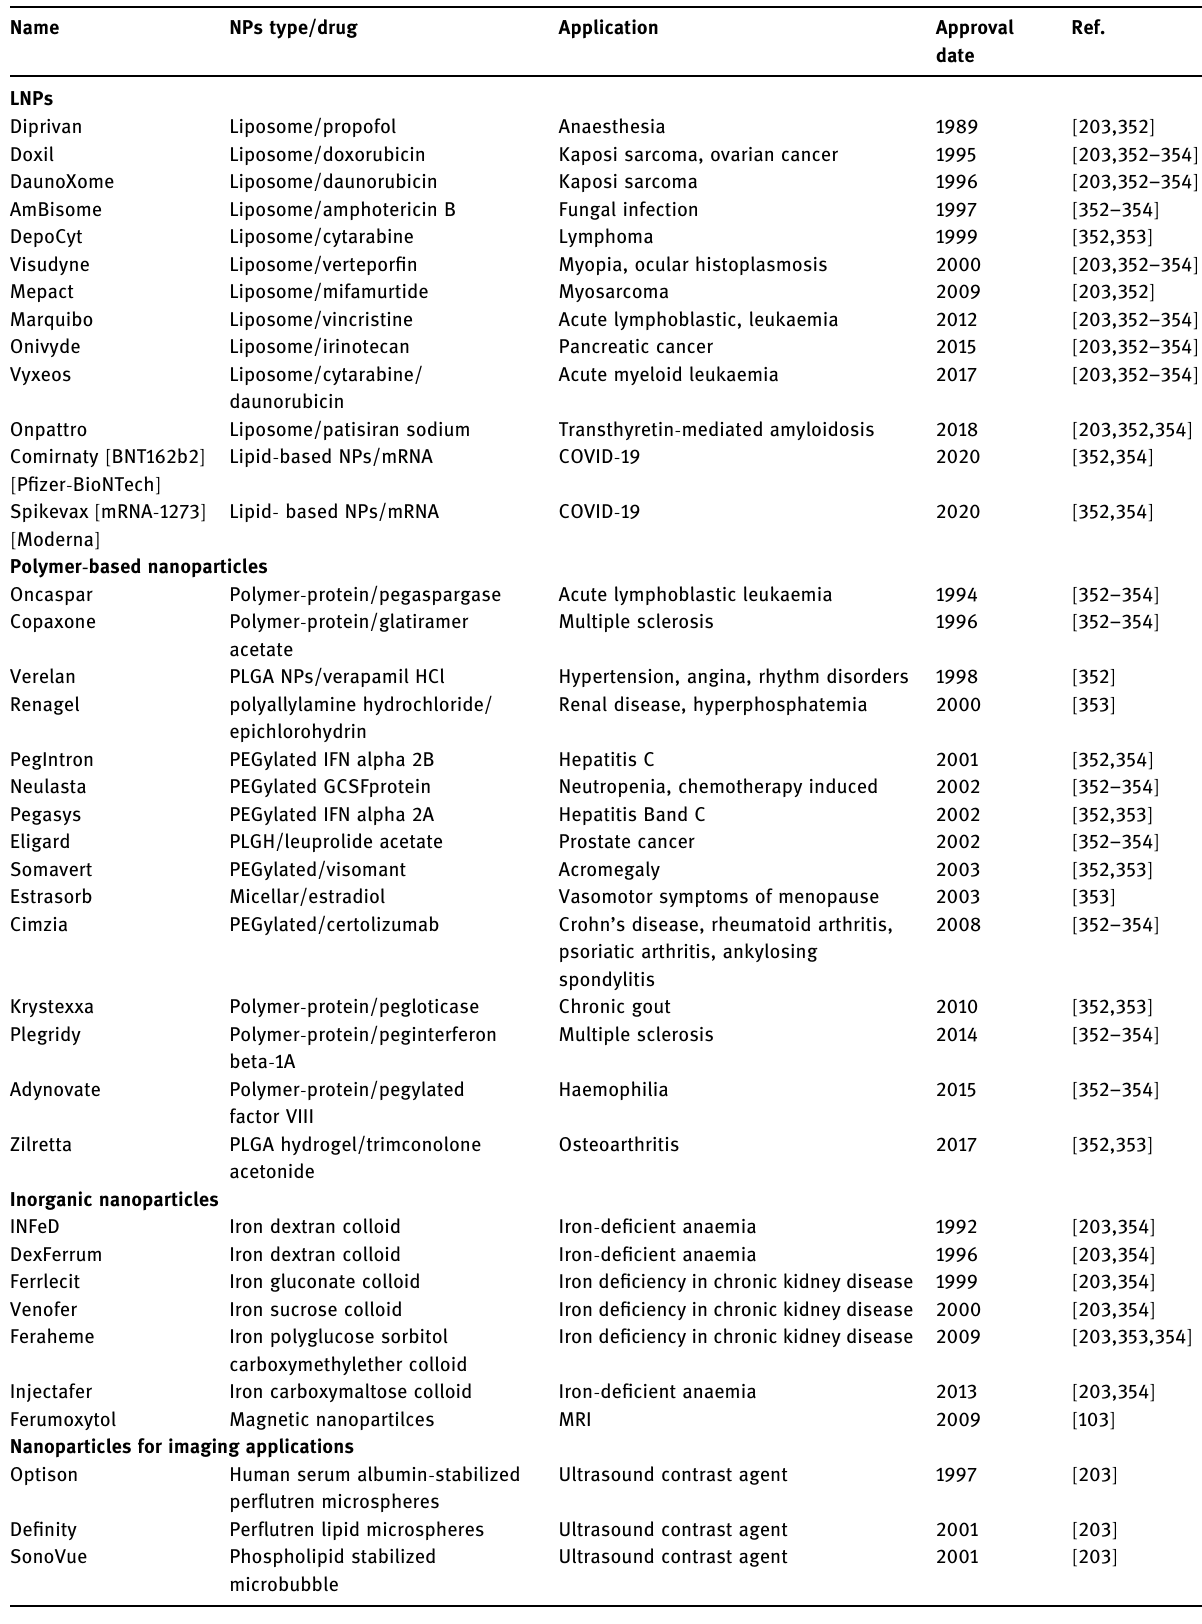
Table 2: Approved marketed nanoparticles and their application in biomedicine